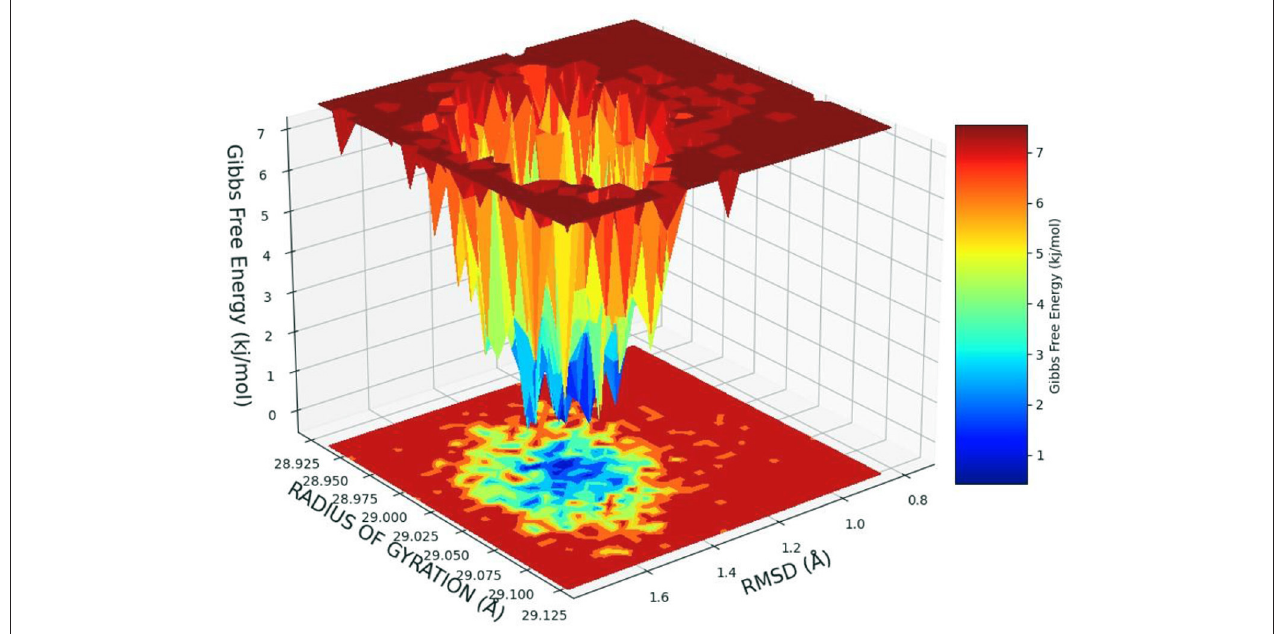
FIGURE 6 | Free energy landscape displaying the achievement of global minima ( 1 G, kJ/mol) of HDAC 2 in the presence of cinnamyl dihydrocinnamate (CMNPD5348) concerning their RMSD (Å) and radius of gyration (Rg,